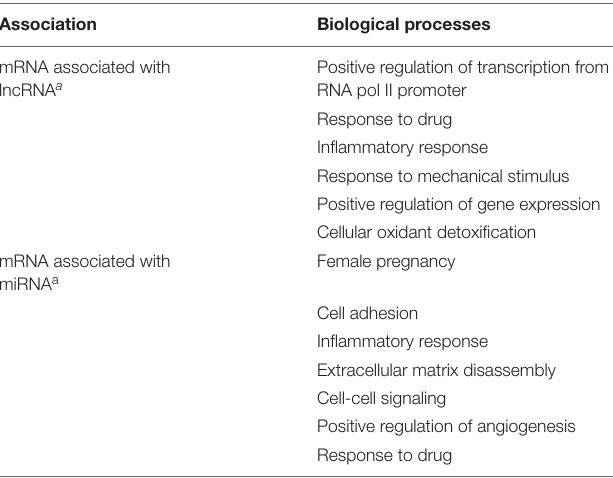
TABLE 2 | Biological processes enriched in mRNAs that exhibited a concordant expression change during trophoblast differentiation a and ranked by adjusted p -value.